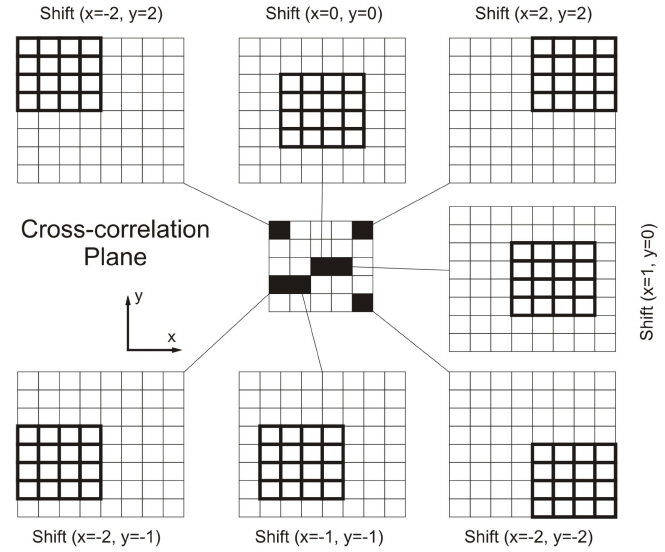
Figure 6. Cross-correlation plane derived from the cross-correlation function using an interrogation window 4 ˆ 4 in